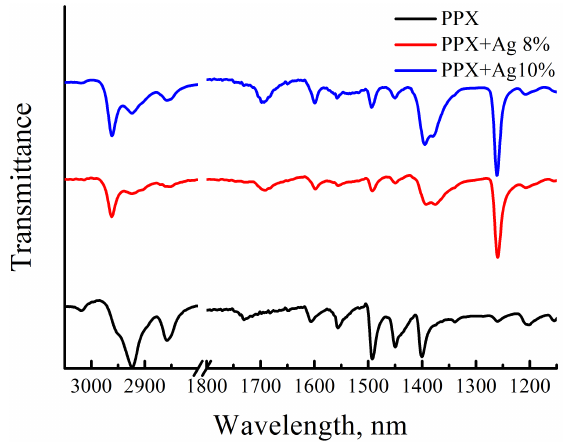
Figure 3. The infrared spectra of PPX+Ag coatings with different concentrations of silver.